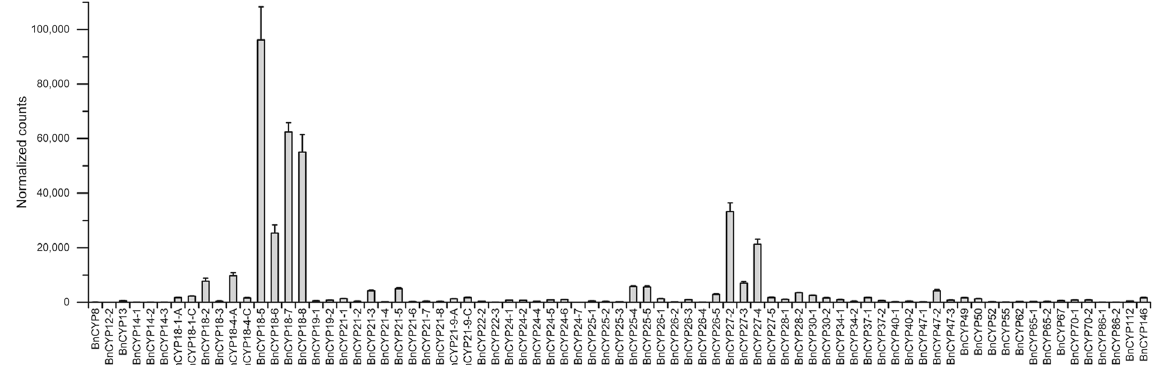
Figure 5. Expression pattern of BnCYP genes from leaf material. In case of two genes encoding the same BnCYP protein, the transcript is abbreviated by its BnCYP name with -A or -C depending on the chromosomal location of the gene, respectively. Raw data are provided in Supplementary Table S2.